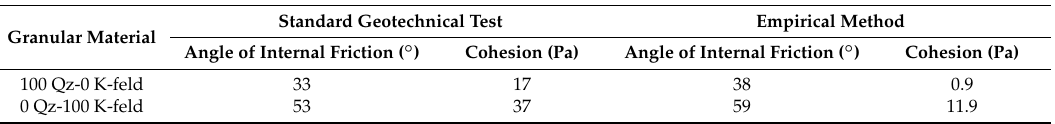
Figure 11. The ring-shear apparatus used in this study and an example of the test results. The curves on the right referr to different applied normal stress ranging from 1.8 kPa (blue line) to 4.4 kPa (green line). Table 8. Comparison between the angle of internal friction and cohesion values (peak friction) obtained with the ring shear test and with adopted empirical methods.